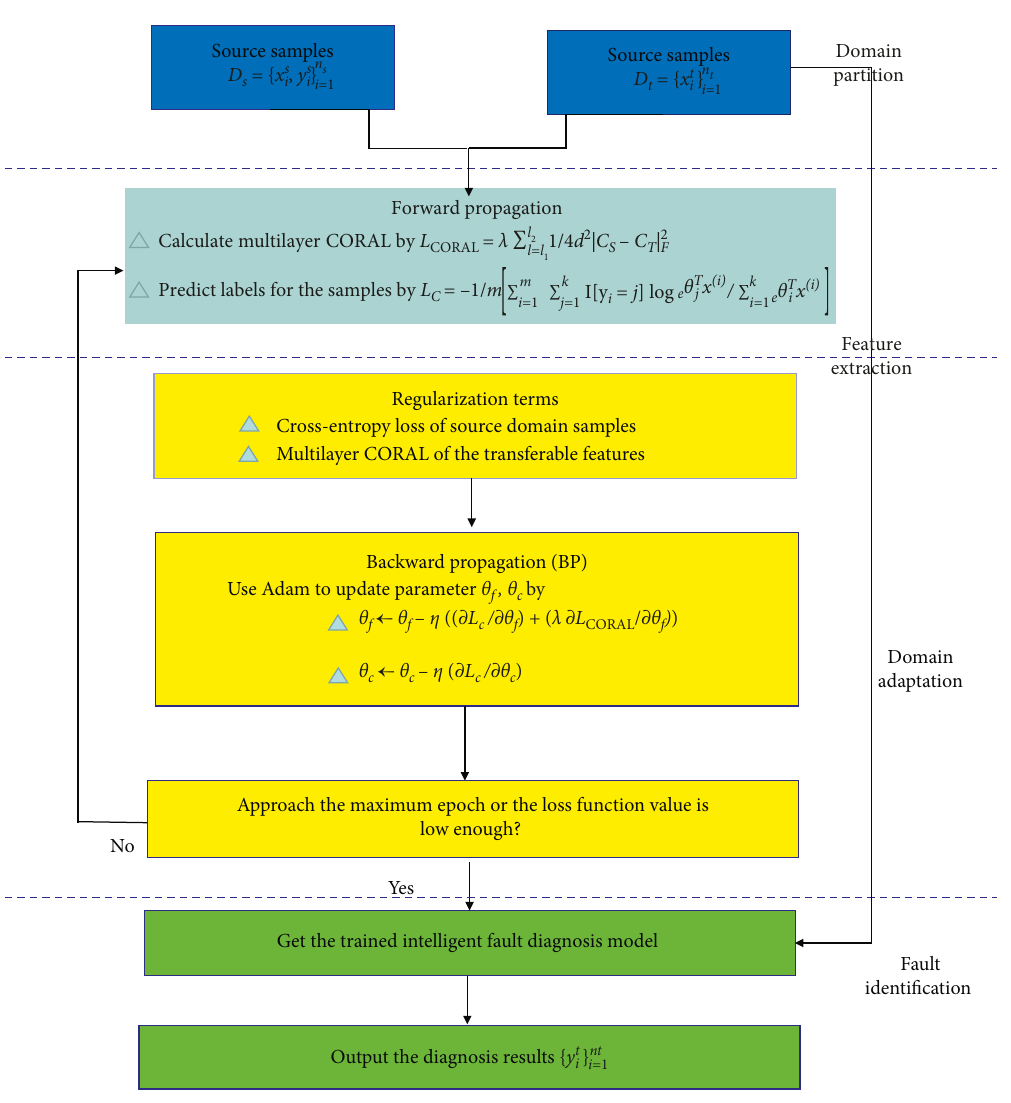
Figure 3: The flowchart of our method.